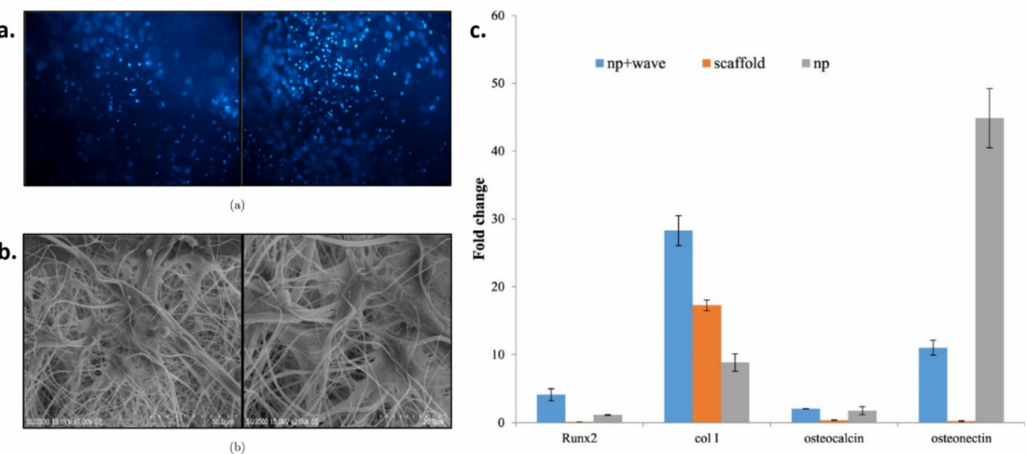
Figure 6. DAPI stained hMSCs 3 days post seeding on CA (left) and CA / rGO-Co (right) sca ff olds ( a ) SEM images of the stem cells seeded on CA (left) and CA / rGO-Co (right) nanofibrous sca ff olds ( b ) Relative expressions of Run × 2, Col1, OCN and OC genes for hMSCs cultured on CA and CA / rGO-Co, with (np + wave) or without (np) AMF ( c ) [101]. Reproduced with copyright